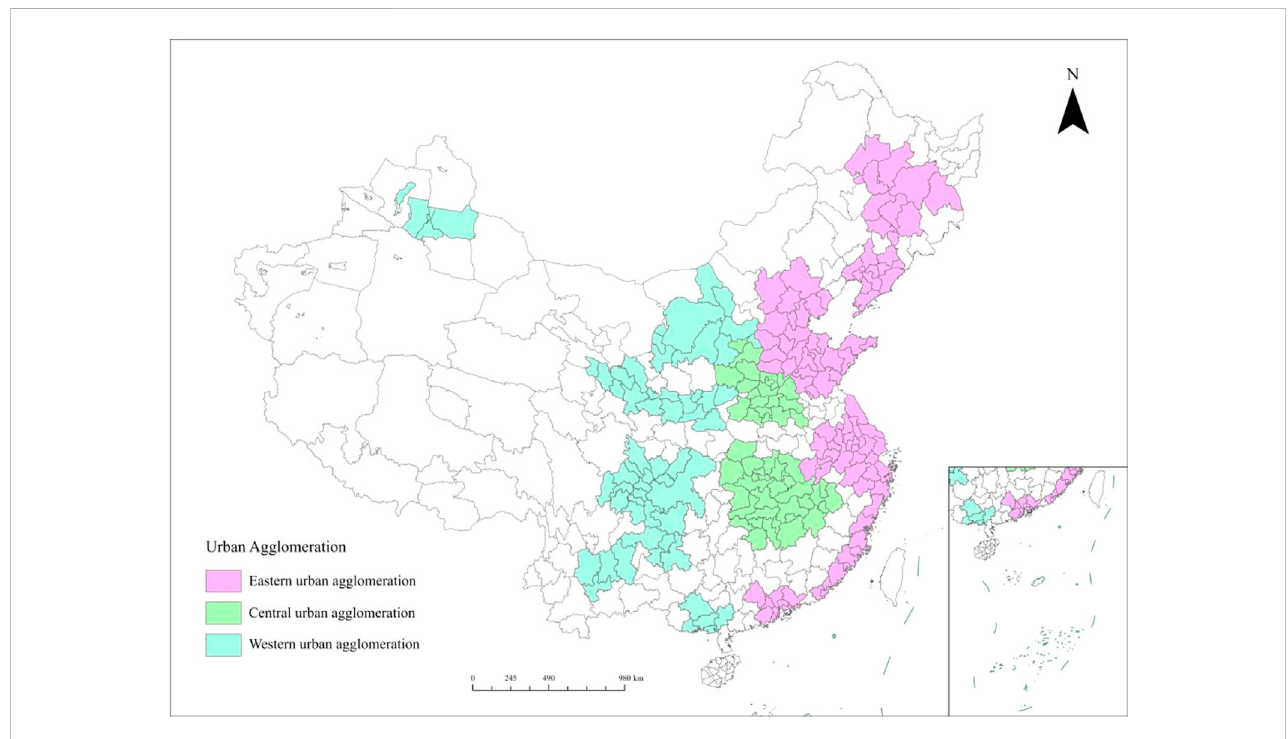
FIGURE 1 The distribution of urban agglomeration in mainland